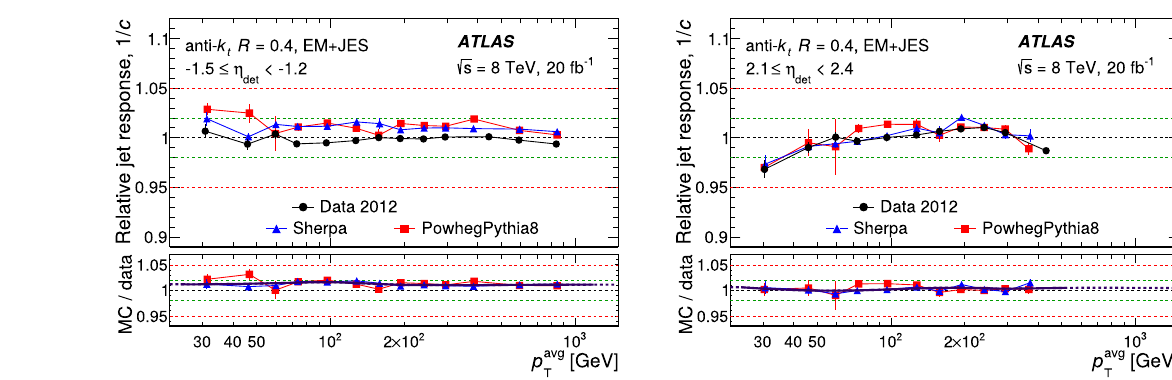
relative response, while the thick line indicates the resulting residual correction. The dashed part of this line represents the extrapolation of the ratio into regions which are statistically limited. The dashed lines in the lower panels indicate 1 ± 0 . 02 and 1 ± 0 .